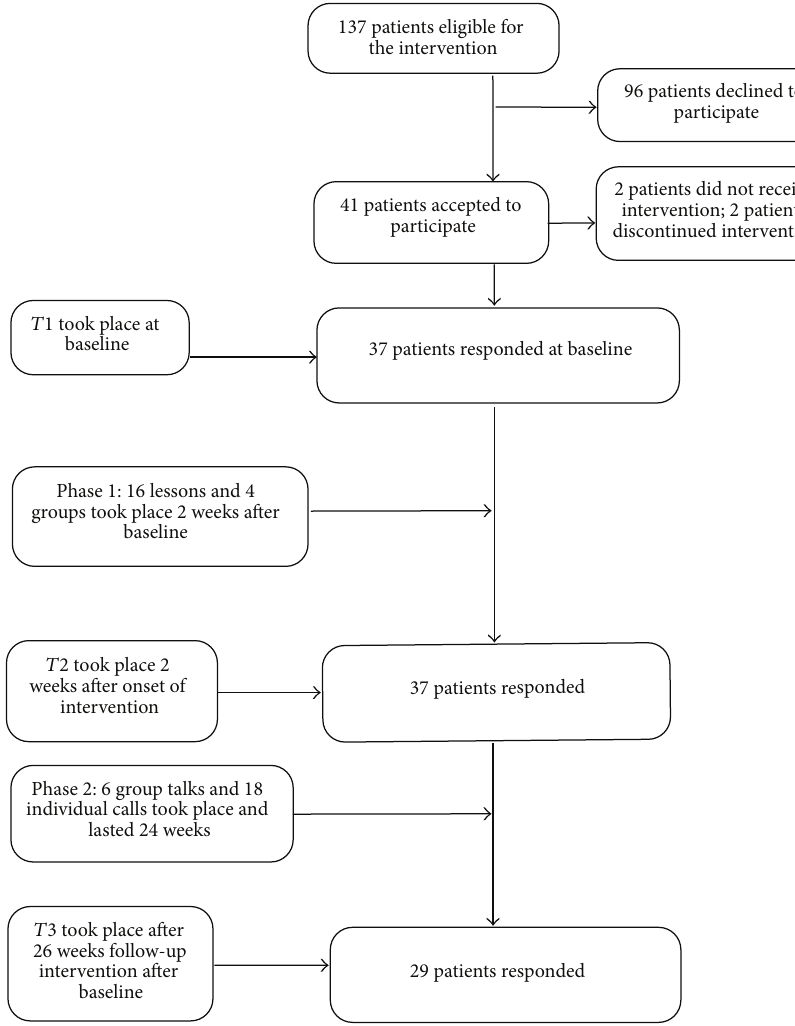
Figure 1: Flow diagram for the participants of the intervention and the time of test